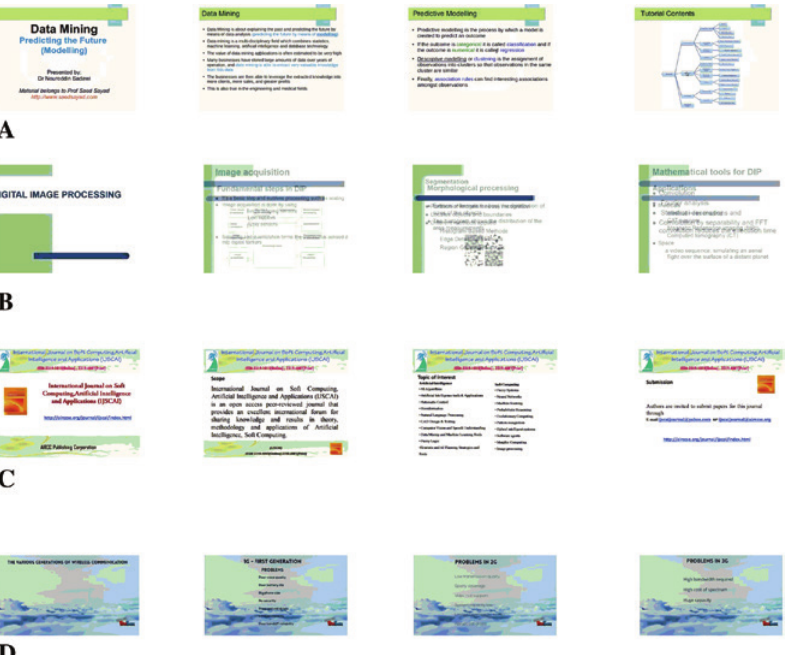
Figure 2: Visualization of Key